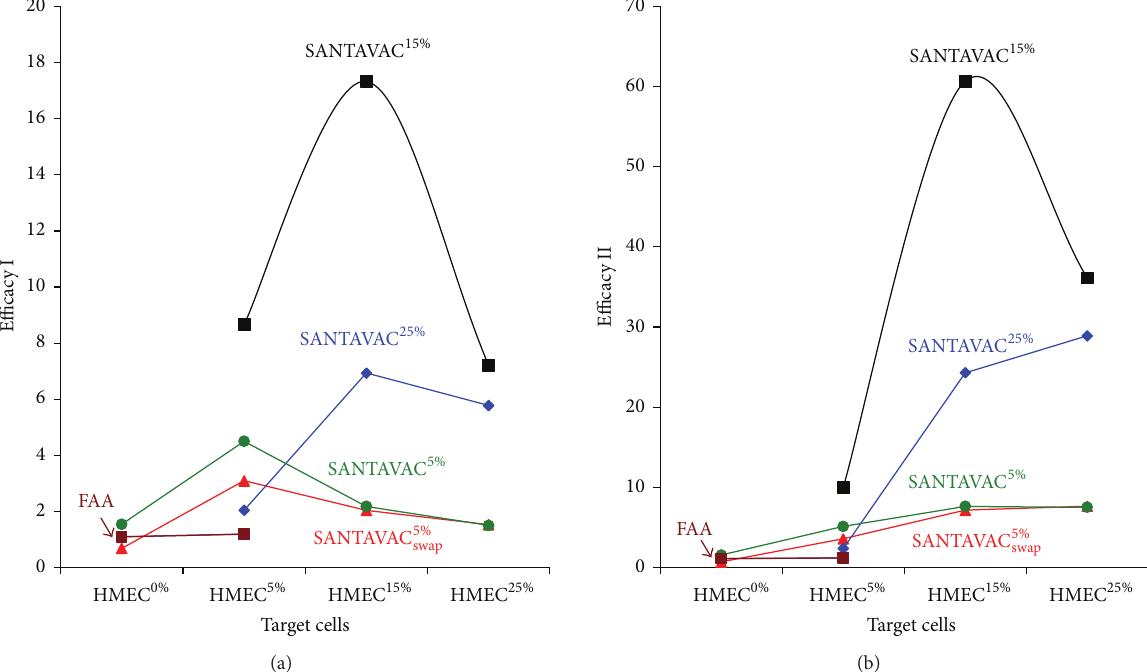
Figure 3: Efficacy I (a) and efficacy II (b) of target cell killing by SANTAVAC in CTA. Target HMEC were incubated in the presence of effector CTL at a 1: 20 ratio. After 3 days, CTL were removed, target cells were carefully washed, and target cell viability was determined. Data is expressed as efficacy I (a) or efficacy II (b) of target cell killing by SANTAVAC. Efficacy I was calculated as a ratio of the number of nonstimulated cells in control wells ( i.e ., HMEC 0 % ) to the number of tumor-stimulated cells in experimental wells. Efficacy II was calculated as a ratio of the number of tumor-stimulated cells in control wells ( i.e ., HMEC 5 % , HMEC 15 % , or HMEC 25 % ) to the number of tumor-stimulated